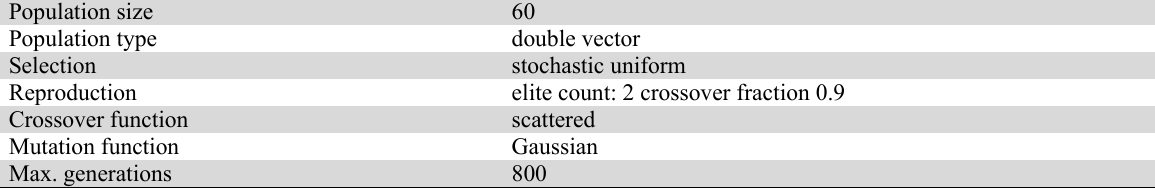
Fig. 6. Interaction effects of the tire design parameters on the strain energy density at belt edge (a,b,c) and strain energy density at chafer (d,e,f) Main parameter values of the GA used in the optimization